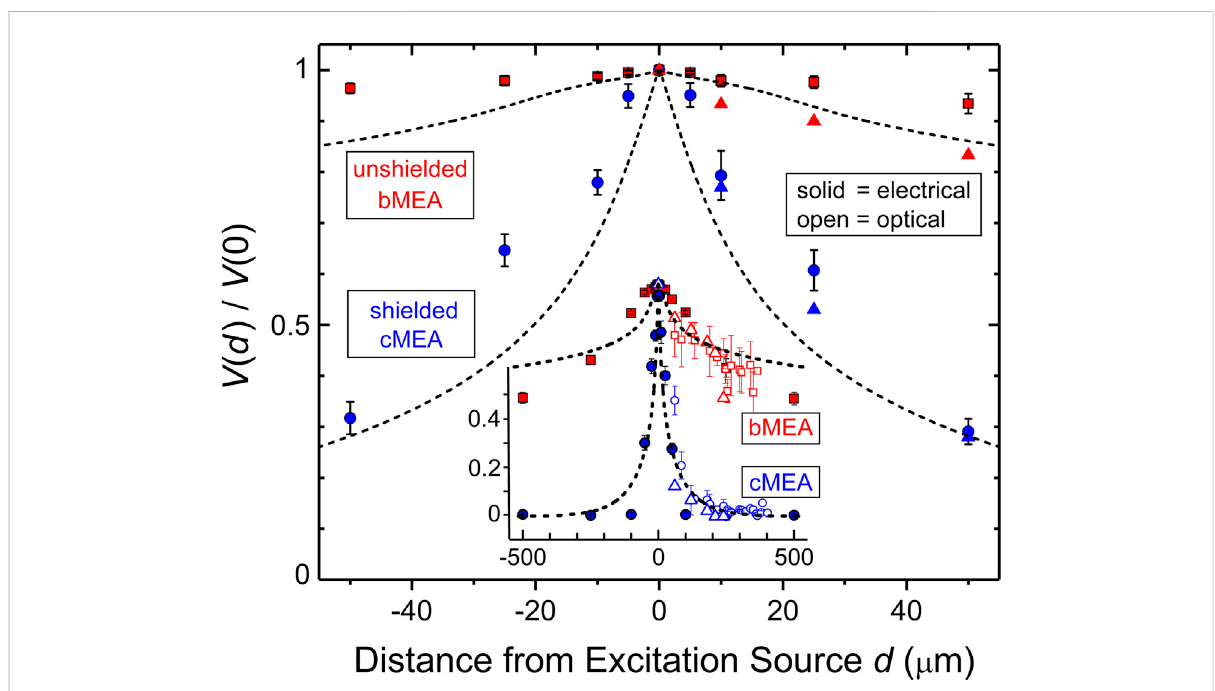
FIGURE 5 Comparisonofexcitationanddevicetypes.Mainpanel:Effectivecrosstalkcoef fi cient V ( d )/ V o vs.distance d fromexcitationsourceforelectrical excitation experiments, for both unshielded bMEA (red symbols) and shielded cMEA (blue symbols) devices. Inset: Wider range of data, out to d = 500 μ m, for both electrical (solid symbols) and optical (open symbols) stimulation. Standard deviations are indicated. Lines are results from simulationsofelectricalresponseversus d ,forbothtypesofdevices.Differentsymbolsforsameconditionsrefertoresultsondifferentidentical devices. Data from fi ve-sweep trials were averaged and mean values plotted with error bars showing ± standard